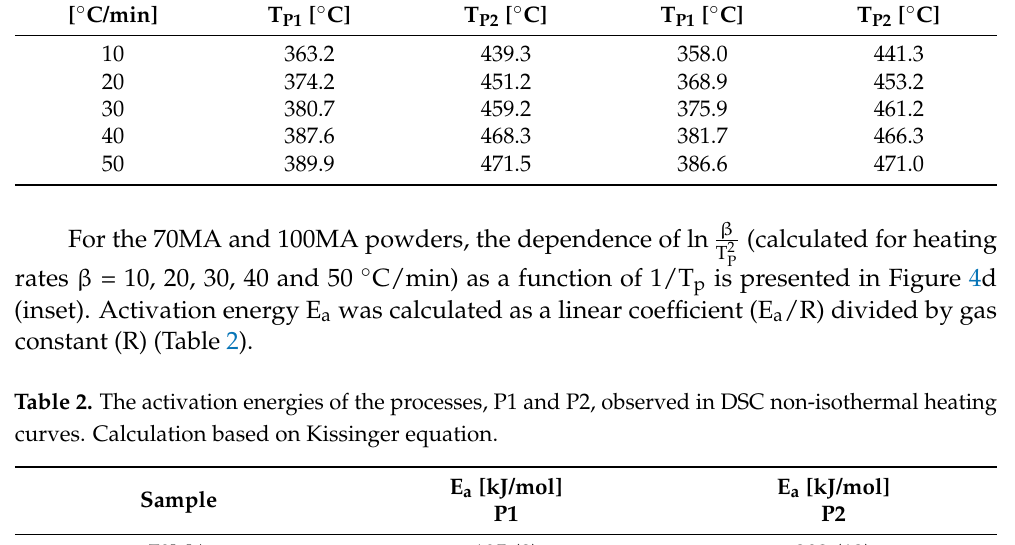
Table 1. T P1 , T P2 —peak temperatures of P1 and P2 process observed in non-isothermal DSC heating curves recorded with 10 ◦ C/min, 20 ◦ C/min, 30 ◦ C/min, 40 ◦ C/min, and 50 ◦ C/min heating rate ( β ). β